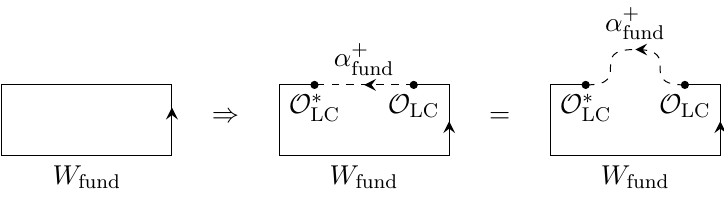
Figure 5. A segment in a Wilson loop W fund can be replaced by the topological line (cid:11) + the line-changing operator O LC = O (cid:11) causes an e(cid:11)ect proportional to the length of the replacement. After the replacement, we can arbitrarily deform the topological line (cid:11) + line has perimeter law { it is the existence of the generally non-invertible topological line (cid:11) +